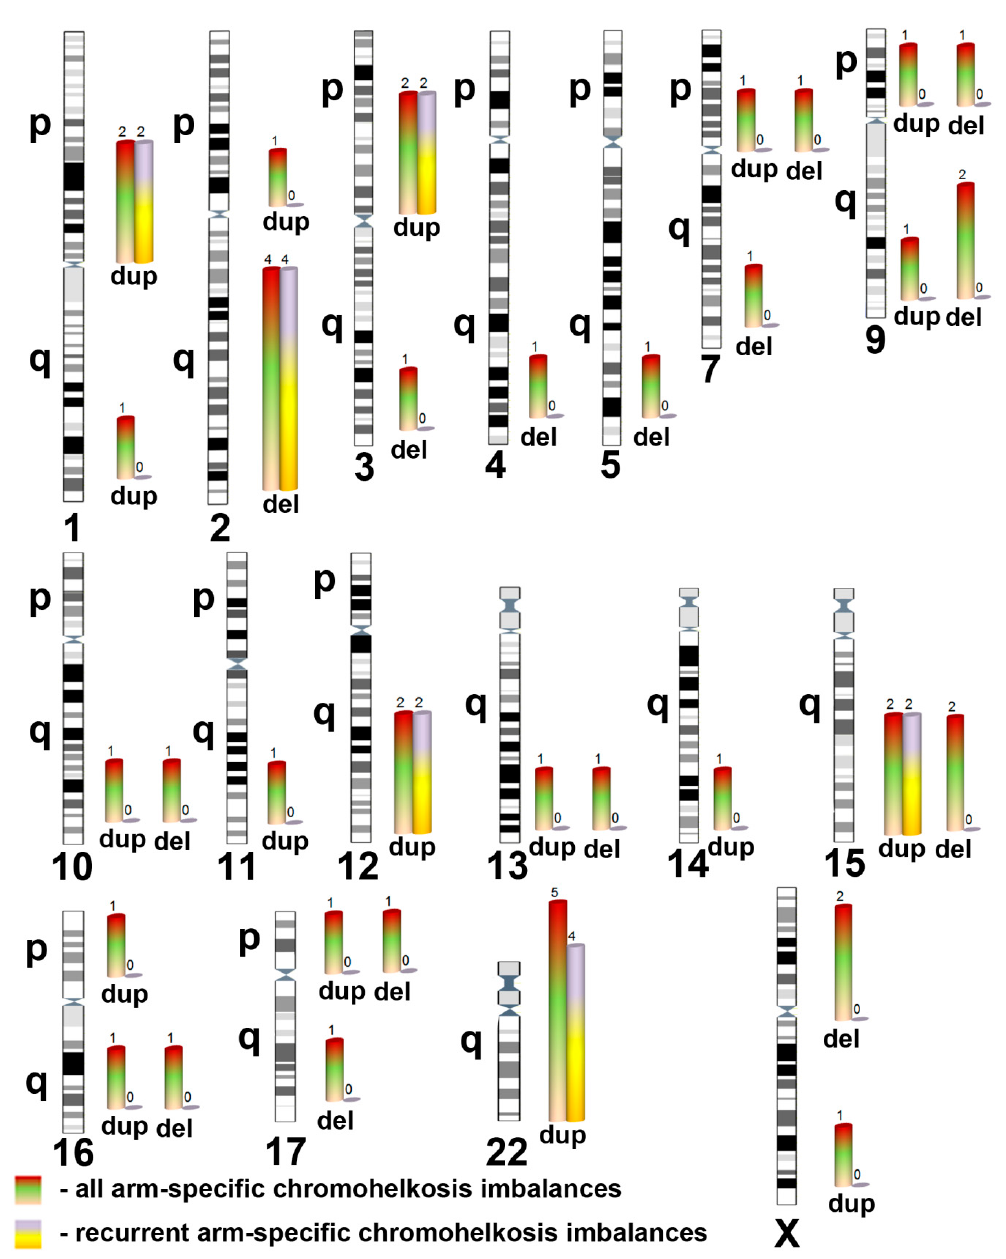
Figure 2. Spectrum of chromohelkosis imbalances classified according to chromosome arms and recurrence at the same chromosomal locus, encompassing the same genomic region (del—deletion; dup—duplication). Two differently colored bars show number of chromohelkosis imbalances per chromosome. The scale of bar length is the same for all chromosomes, whereas the scale of chromosomes is conserved.